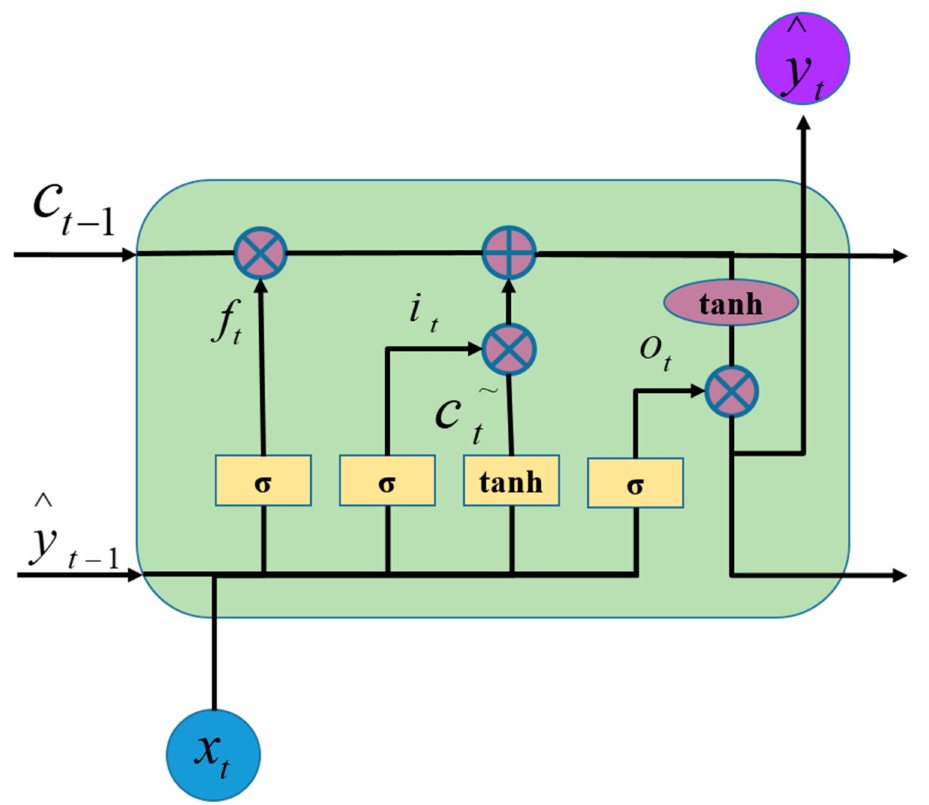
Figure 5. Memory block structure of